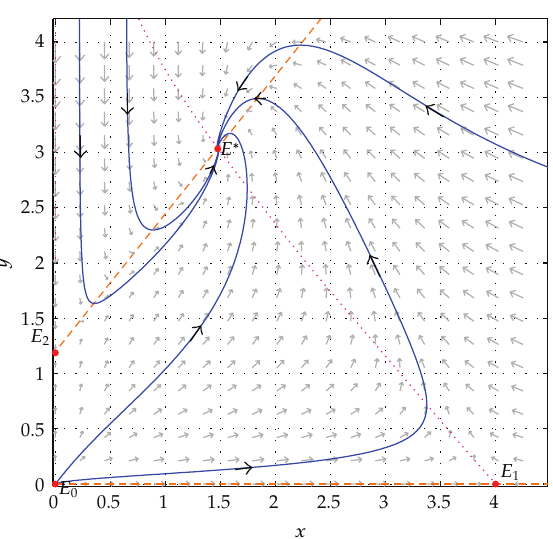
Figure 3: The phase portraits of model (cid:4) 1.3 (cid:5) . The parameters are taken as a (cid:6) 2 , b (cid:6) 0 . 25 , c (cid:6) 0 . 875 , e (cid:6) 1, m (cid:6) 0 . 95 , n (cid:6) 0 . 9 , and f (cid:6) 0 . 8. In this case, E 1 (cid:6) (cid:4) 4 , 0 (cid:5) and E 2 (cid:6) (cid:4) 0 , 1 . 1875 (cid:5) are saddle points, the positive interior equilibrium point E ∗ (cid:6) (cid:4) 1 . 4761 , 3 . 0326 (cid:5) is globally asymptotically stable. The dashed curve is the x -nullcline f (cid:4) x,y (cid:5) (cid:6) 0, and the dotted curve is the y -nullcline g (cid:4) x,y (cid:5) (cid:6)